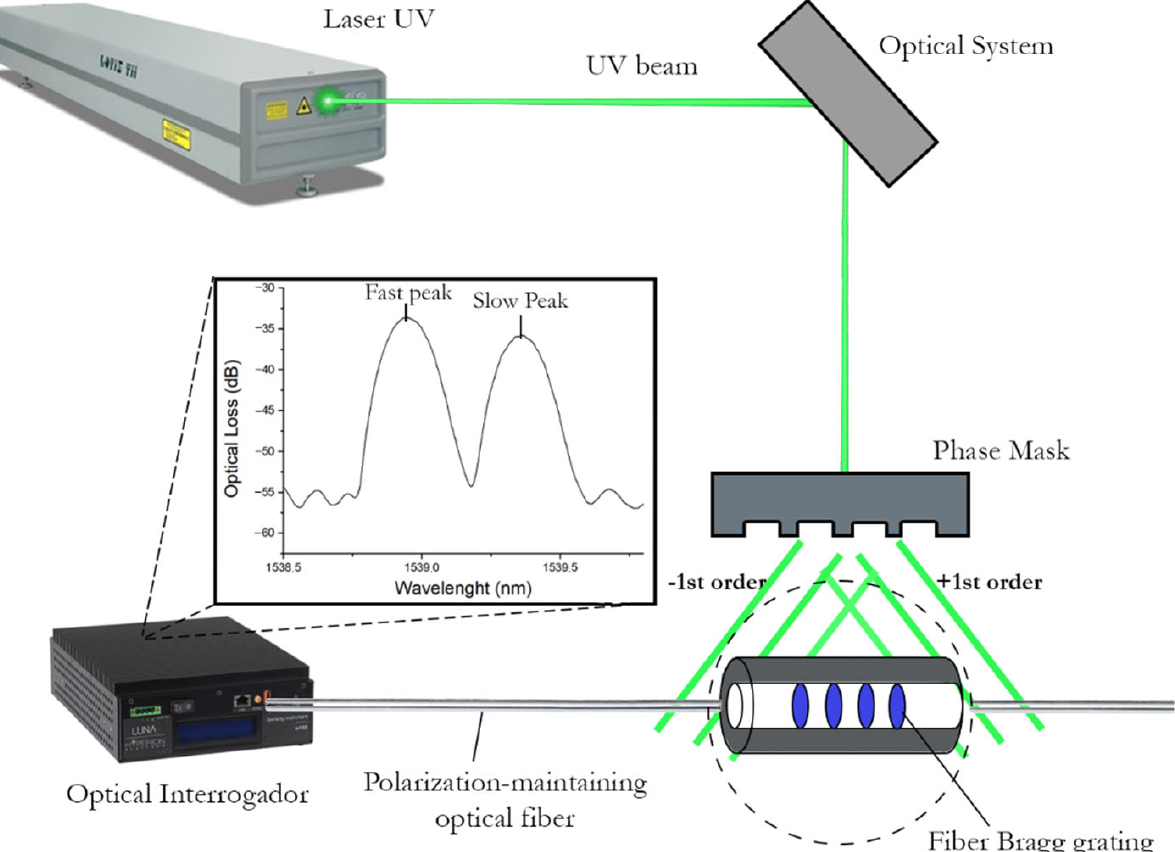
Figure 2. Illustrative scheme of FBG sensor inscription. The phase mask splits the UV beam into secondary beams, − 1st order and +1st order, which interact with the optical fiber core, originating the gratings and the FBG sensor [29]. The birefringence property of the PM optical fibers induces two different propagation modes, resulting in two shifted Bragg wavelengths represented by the fast and slow peaks, as shown in the spectrum read of the optical interrogator.